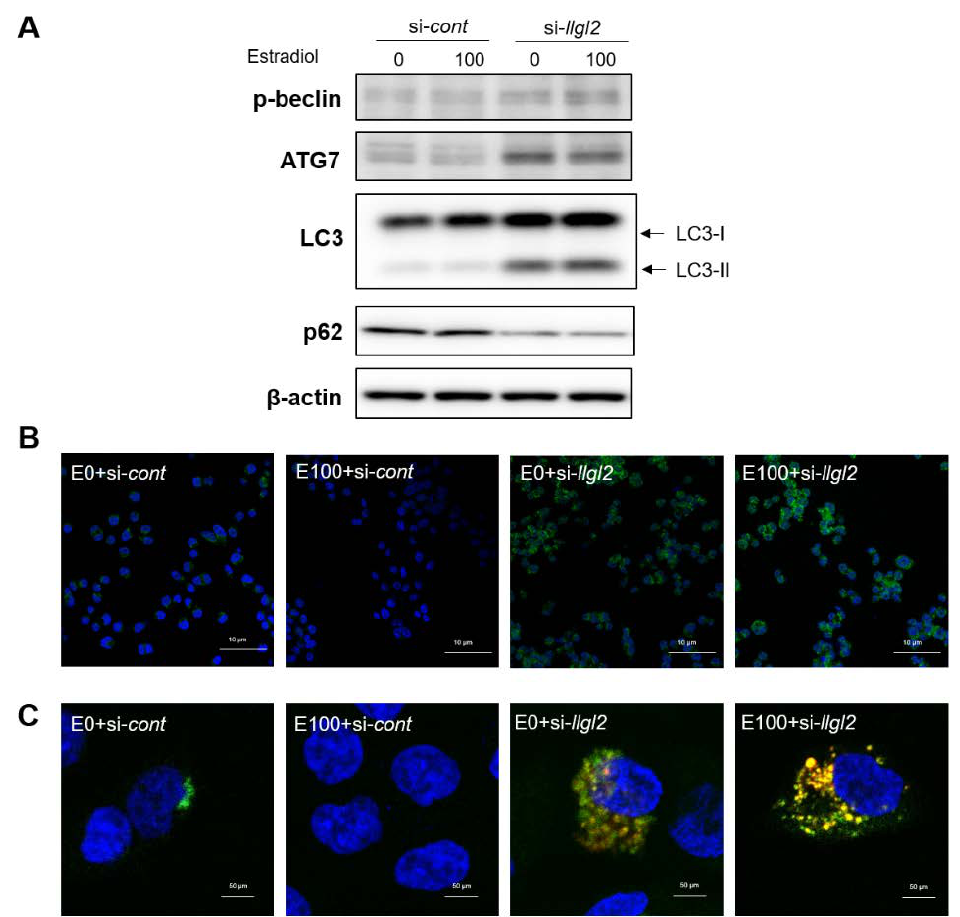
Figure 4. LLGL2 knockdown stimulates autophagosome formation in E2-treated BPH-1 cells. BPH-1 cells were transiently transfected with a negative control siRNA ( si-cont ) or with LLGL2 siRNA ( si-llgl2 ) against LLGL2 for 48 h. After that, cells were treated with E2 (0 and 100 nM) for 24 h. ( A ) Western blot data of p-beclin, ATG7, LC3, and p62 protein expression levels in E2-treated BPH-1 cells after LLGL2 knockdown. ( B ) Representative images of endogenous LC3 puncta in E2-treated BPH-1 cells after LLGL2 knockdown. Cell nuclei were visualized by 6-diamino-2-phenylindole (DAPI; blue) staining and LC3-II was visualized with Alexa 488 conjugate (green) at 400 × magnification. Scale bar = 10 µ m. ( C ) Representative images of RFP-GFP-LC3 tandem fluorescent-tagged LC3 (RFP-GFP- LC3) in E2-treated BPH-1 cells after LLGL2 knockdown at 630 × magnification. Scale bar = 50 µ